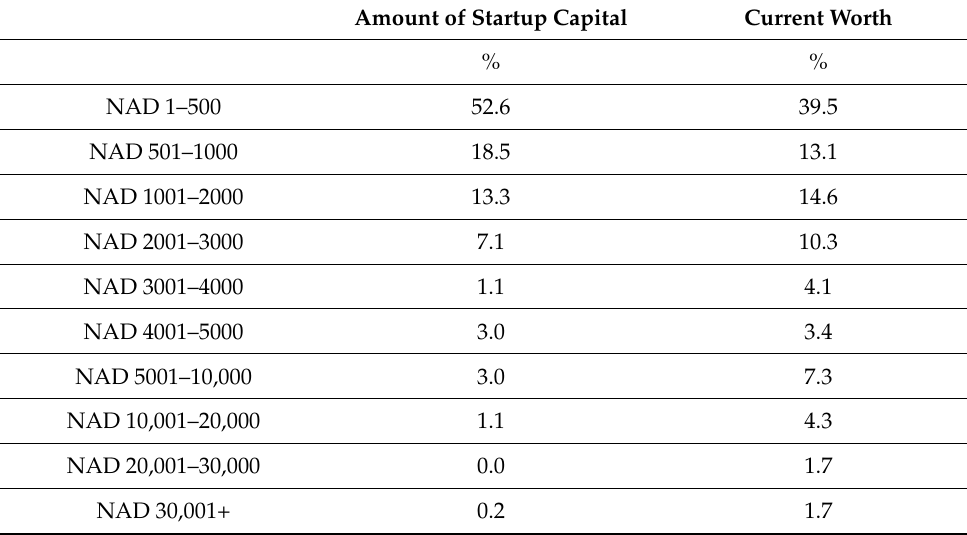
Table 8. Comparison of startup capital and current worth of